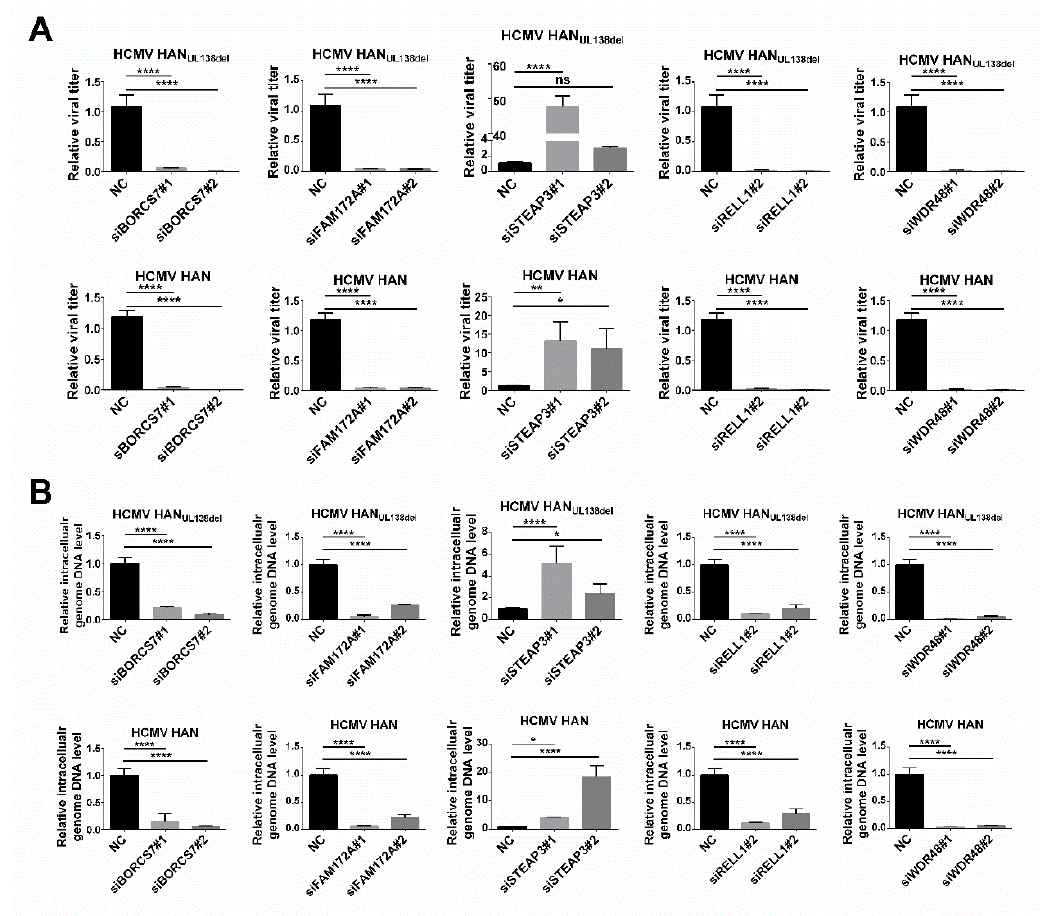
Figure 5. Host proteins di ff erentially regulated by pUL138 at the late stage post HCMV infection can a ff ect HCMV replication. ( A ) The e ff ect of knockdown of BORCS7, FAM172A, RELL1, WDR48 or STEAP3 on HCMV production. MRC5 cells were transfected with siRNA or NC. At 48 h post transfection, the cells were infected with Han or Han UL138del at an MOI of 0.1 or mock-treated. At 5 d post infection, cell culture supernatants were collected, and viral titers in the supernatants were measured. ( B ) The e ff ect of knockdown of BORCS7, FAM172A, RELL1, WDR48 or STEAP3 on intracellular HCMV DNA levels. MRC5 cells were transfected with siRNA or NC. At 48 h post transfection, the cells were infected with Han or Han UL138del at an MOI of 0.1 or mock-treated. At 5 d post infection, the cells were harvested to extract DNA. Intracellular levels of HCMV genomic DNA were detected with primers for UL44 by quantitative RT-PCR analysis.Three replicates were performed, and results are shown as mean ± SD. * p < 0.05; ** p < 0.01; *** p < 0.001; **** p < 0.0001; ns, no significance.